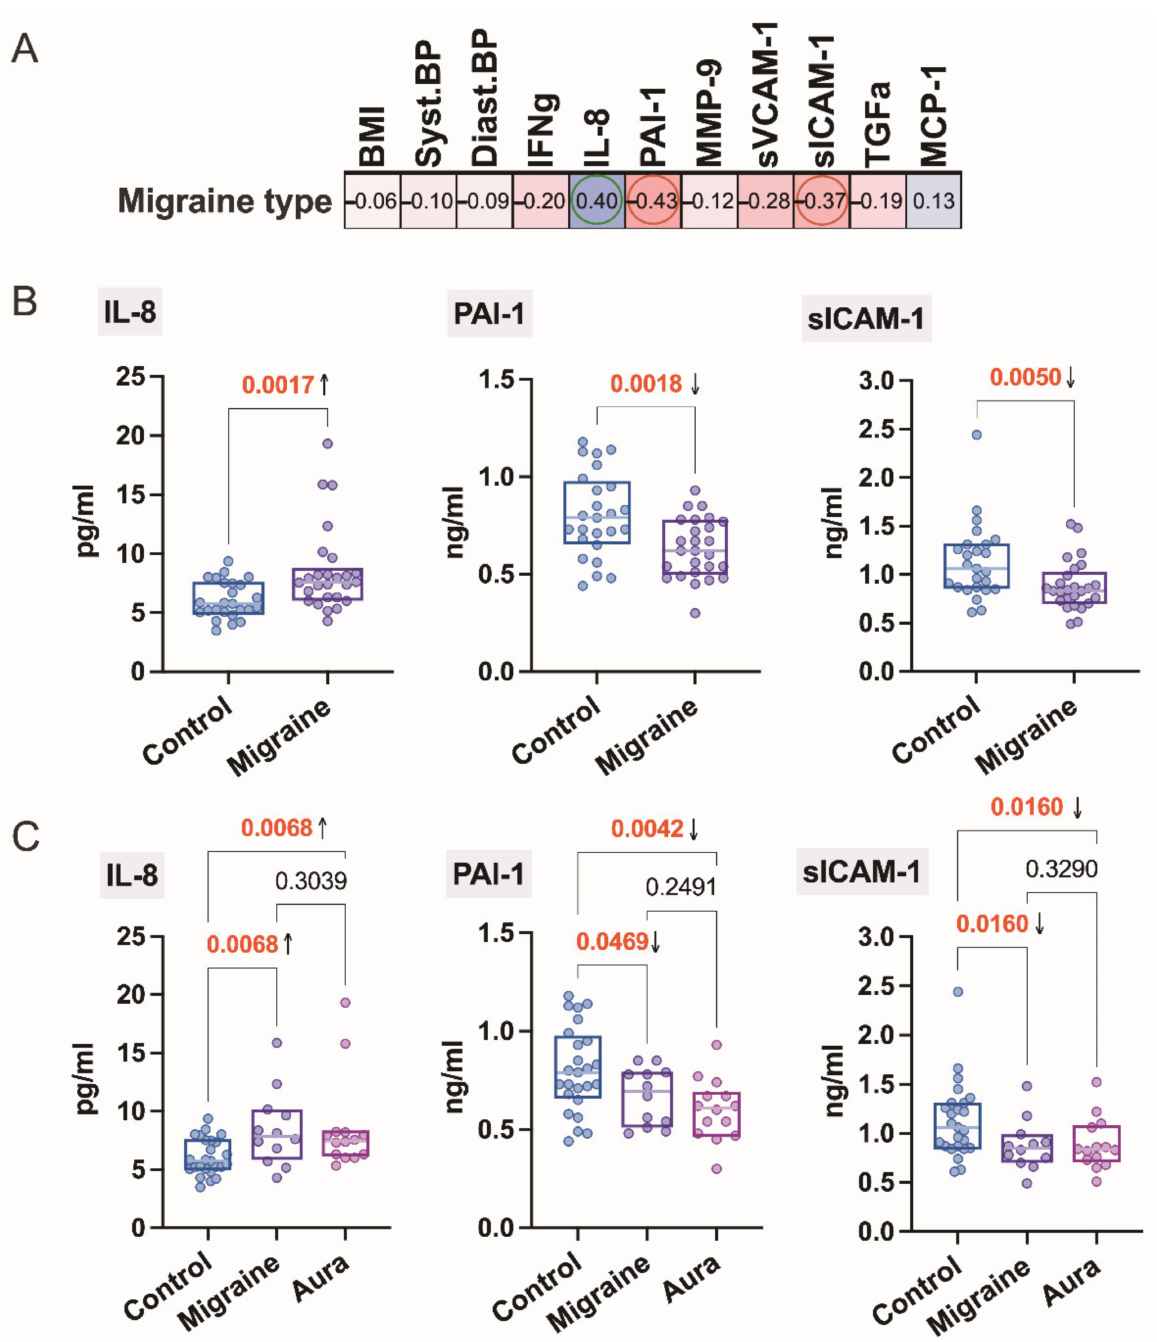
Figure 1. ( A ) Association of BMI, BP, and cytokines regarding migraine type (healthy individuals: control; patients with migraine without aura: migraine and with aura: aura); numbers represent respective Spearman’s rank correlation coefficient. ( B ) Comparison of the concentration of IL-8, PAI-1, and sICAM-1 in the blood of healthy individuals and migraine patients (migraine + aura), Mann– Whitney test. ( C ) Regarding studied types of migraine; Kruskal–Wallis’ test followed by two-stage step-up method of Benjamini, Krieger, and Yekutieli as post-hoc procedure for the adjustments of the significance level for multiple